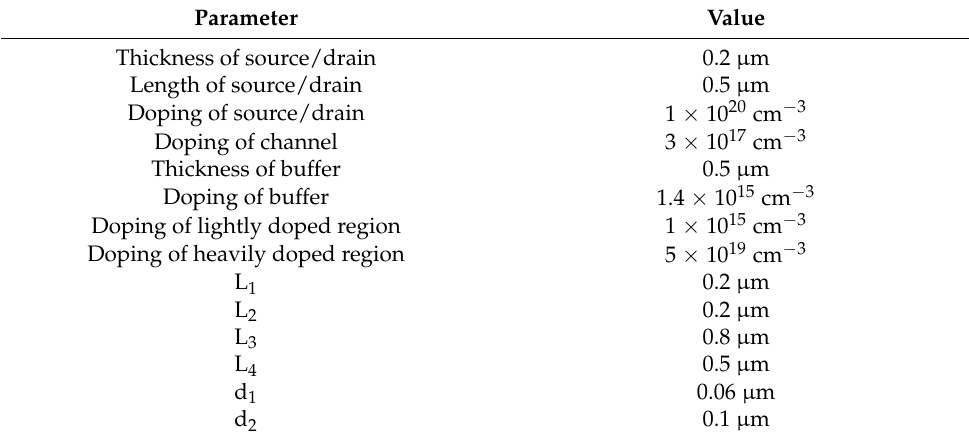
Table 1. Structure parameters of the devices.